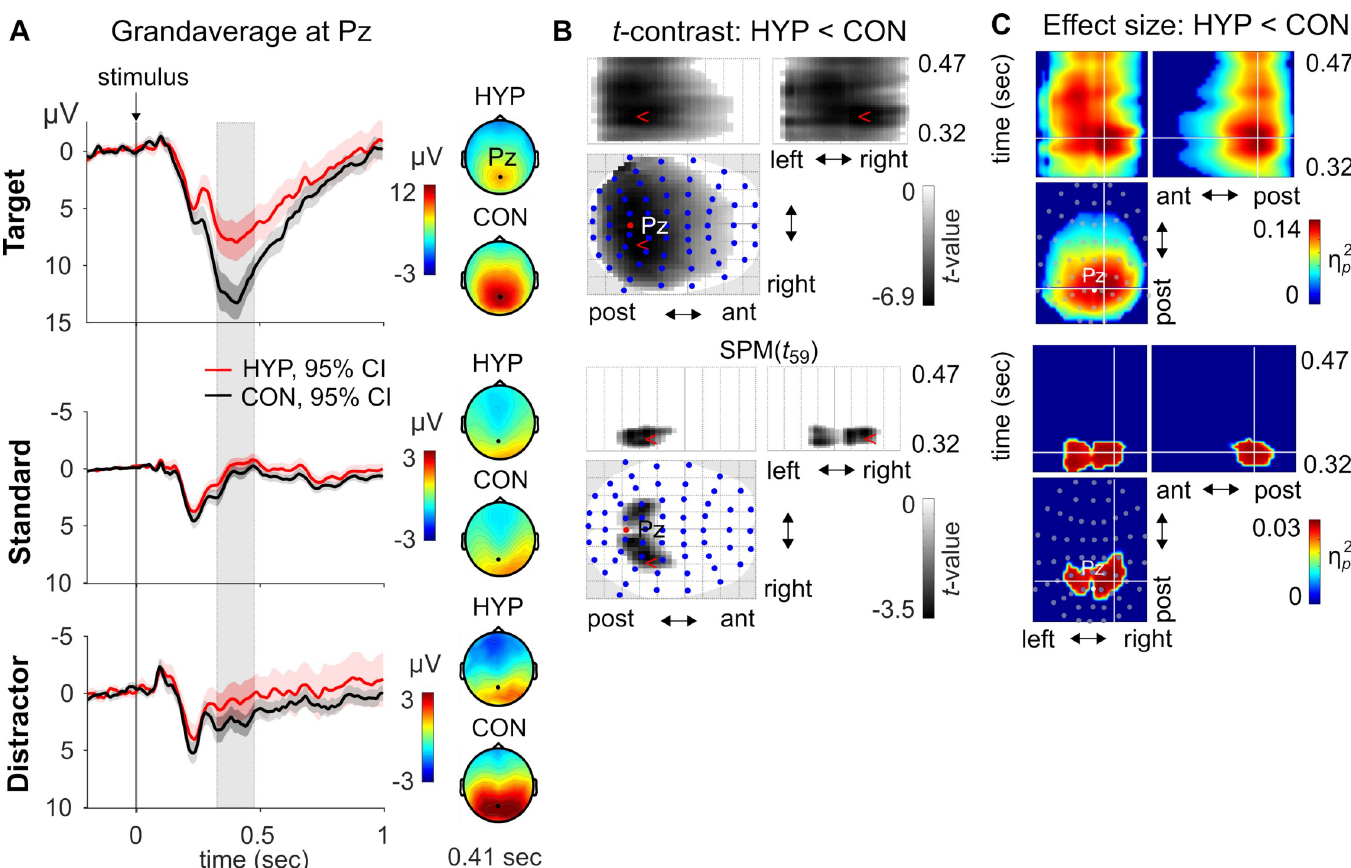
Fig 2. (A) Grandaverage waveforms (pooled across all participants, n = 60) and 95% C.I. in hypnosis (HYP, red) and control condition (CON, blue) for target, distractor, and standard stimulus type at electrode Pz. The grey rectangle marks the P3b time window (320–470 ms) used for statistical analysis of data at sensor- and source-level. Sensor-level topographies at the peak latency of the target P3b (410 ms) depending on condition and stimulus type. (B) For each stimulus type a one-sample t -Test was performed and the results were assessed with a t -contrast to test for differences between experimental conditions, i.e., HYP < CON, within the P3b time window as shown in (A). There were no significant amplitude differences for the distractor between HYP and CON. The summary statistic scalp-time images were thresholded at p < .001 (uncorrected) with FWE correction at cluster-level, p < .05, based on random field theory. The statistical parametric maps (SPMs) are displayed as Maximum Intensity Projection (MIP) of the 3D (scalp x time) summary statistic image. Blue dots mark the electrode sites. post = posterior; ant = anterior (C) Effect size, partial eta square ( Z 2